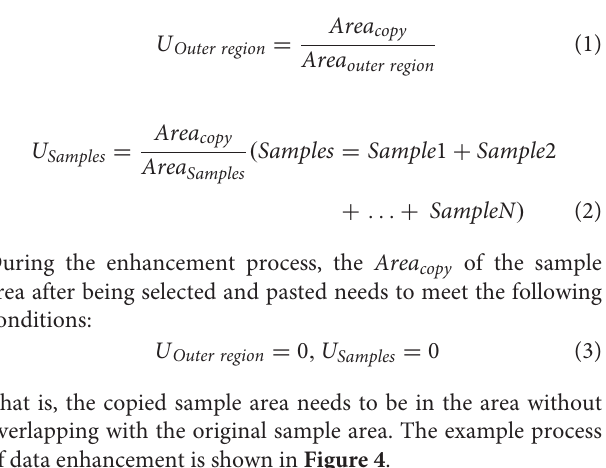
FIGURE 3 | Small sample number enhancement